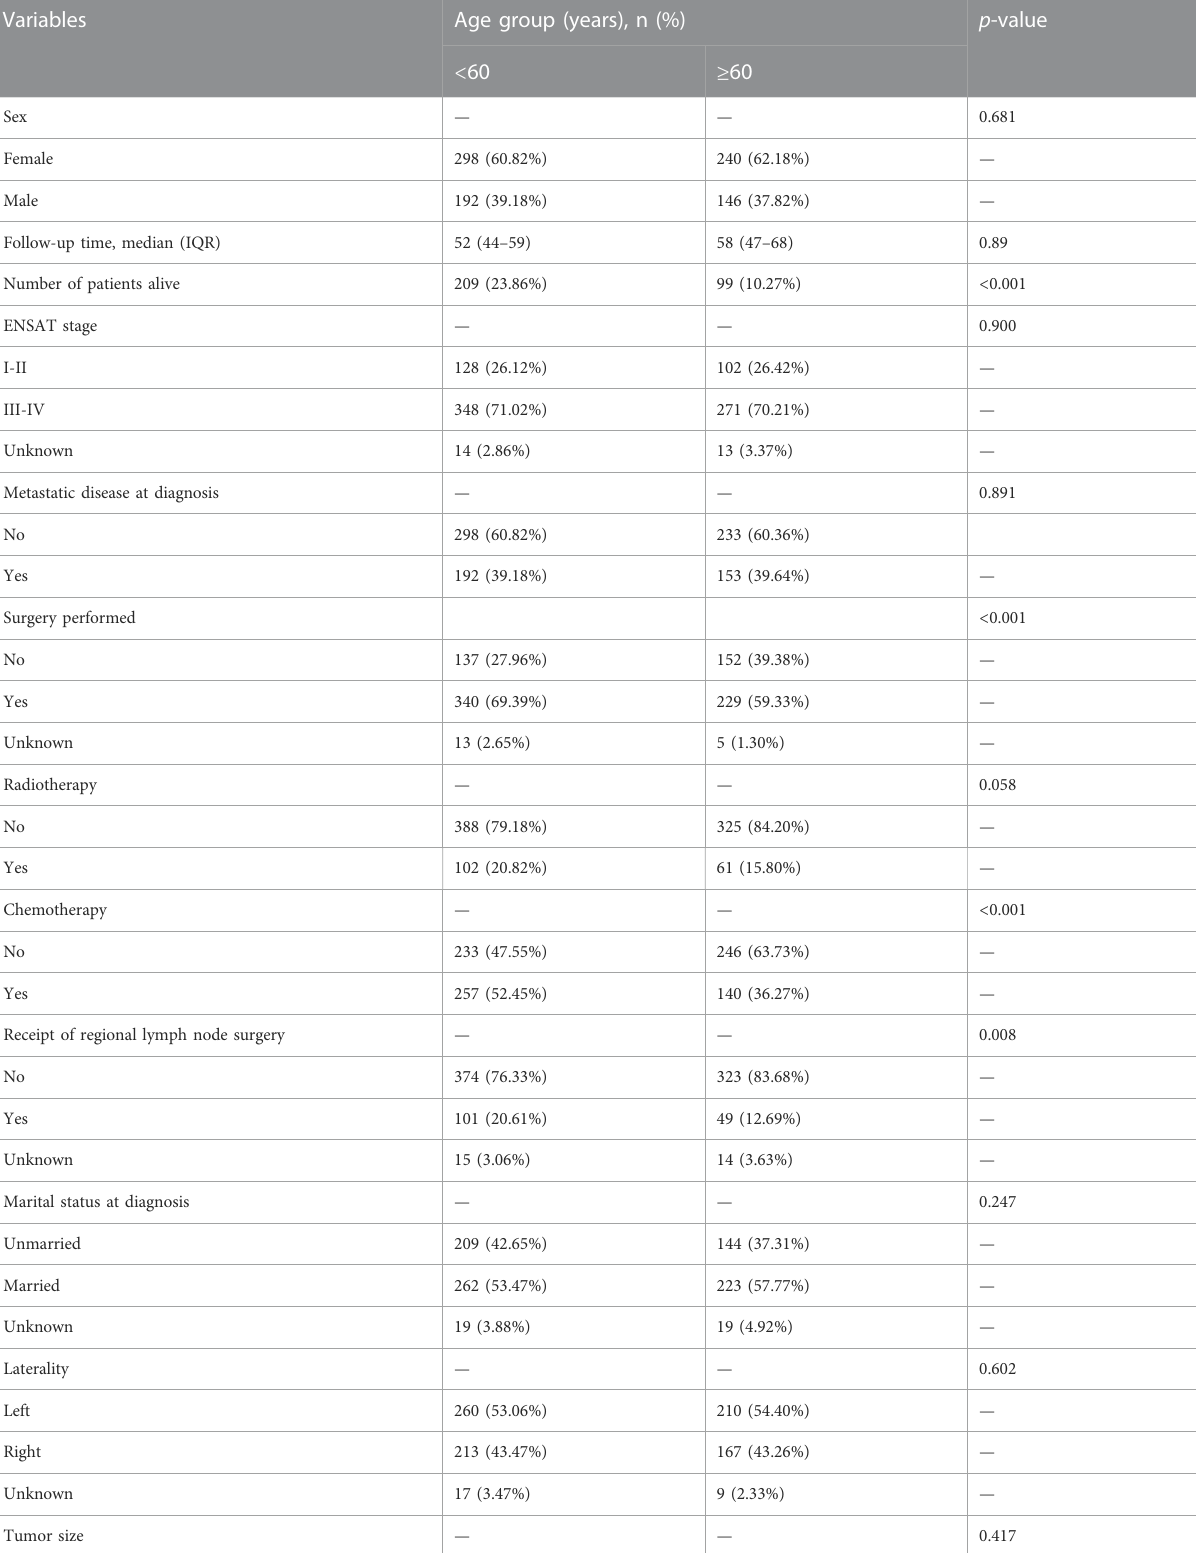
TABLE 1 Baseline demographic and tumor characteristics of patients with